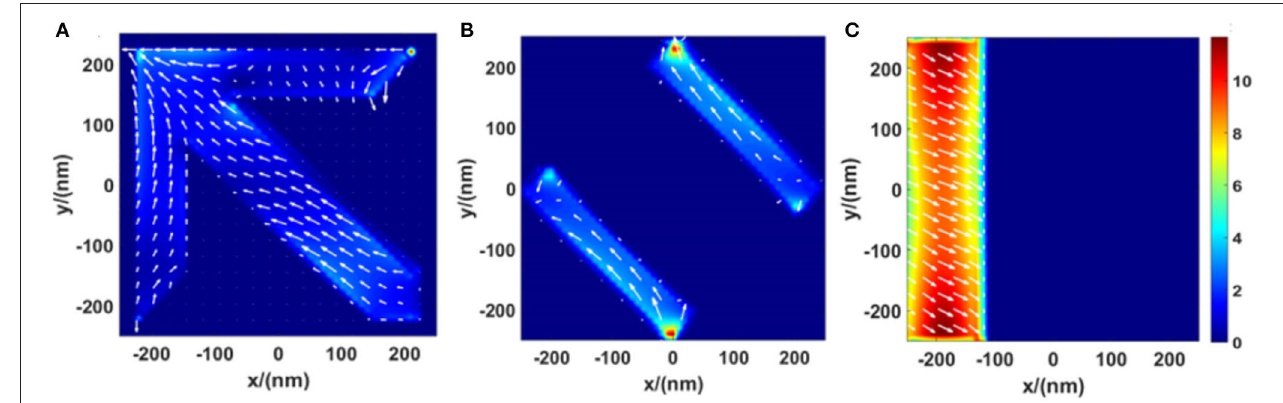
FIGURE 8 | Surface current distributions of (A) the top layer, (B) the bottom layer, and (C) the middle layer for x-polarized incident light at 742nm. The unit of the current density is 105